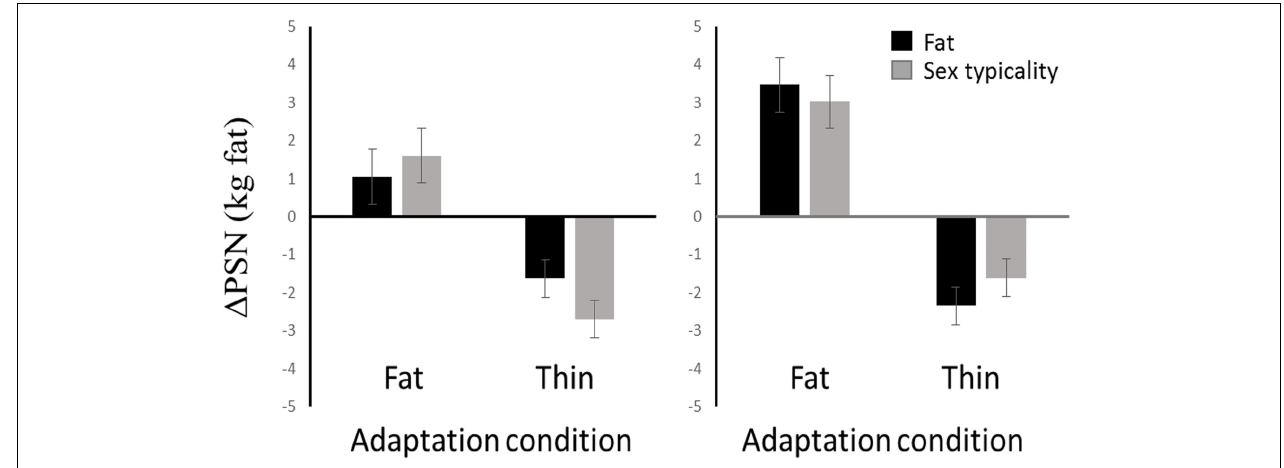
FIGURE 3 | Magnitude and direction of adaptation effects to fat and thin bodies. Black bars show the fatness attention condition. Gray bars show the sex typicality attention condition. Female data are presented in the (Left) and male data in the (Right). Error bars show standard error of the mean. All adaptation effects are in the predicted